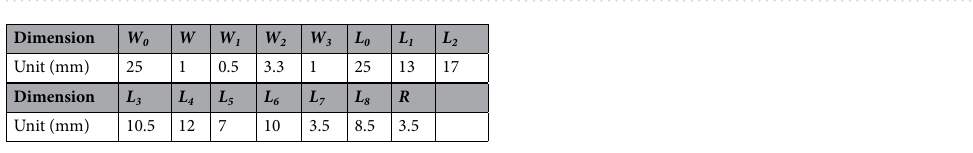
Table 1. Detailed dimensions of the